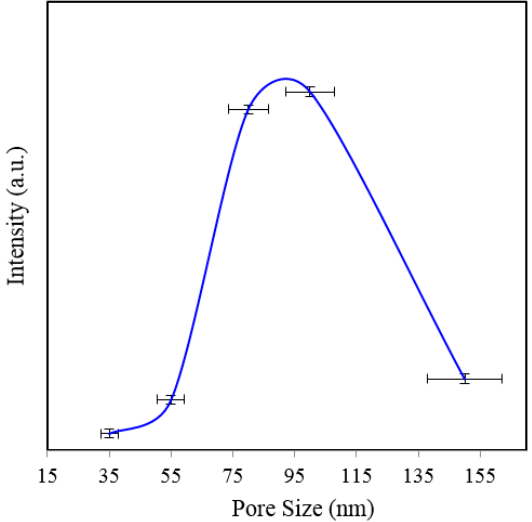
Figure 9. Comparison of SERS intensities at about 1361 cm − 1 measured from 8 × 10 − 5 M solution of Rh6G dye adsorbed on the surface of 120 nm gold films deposited on 35, 55, 80, 100, and 150 nm NAAO SERS substrate at 3 s integration time.